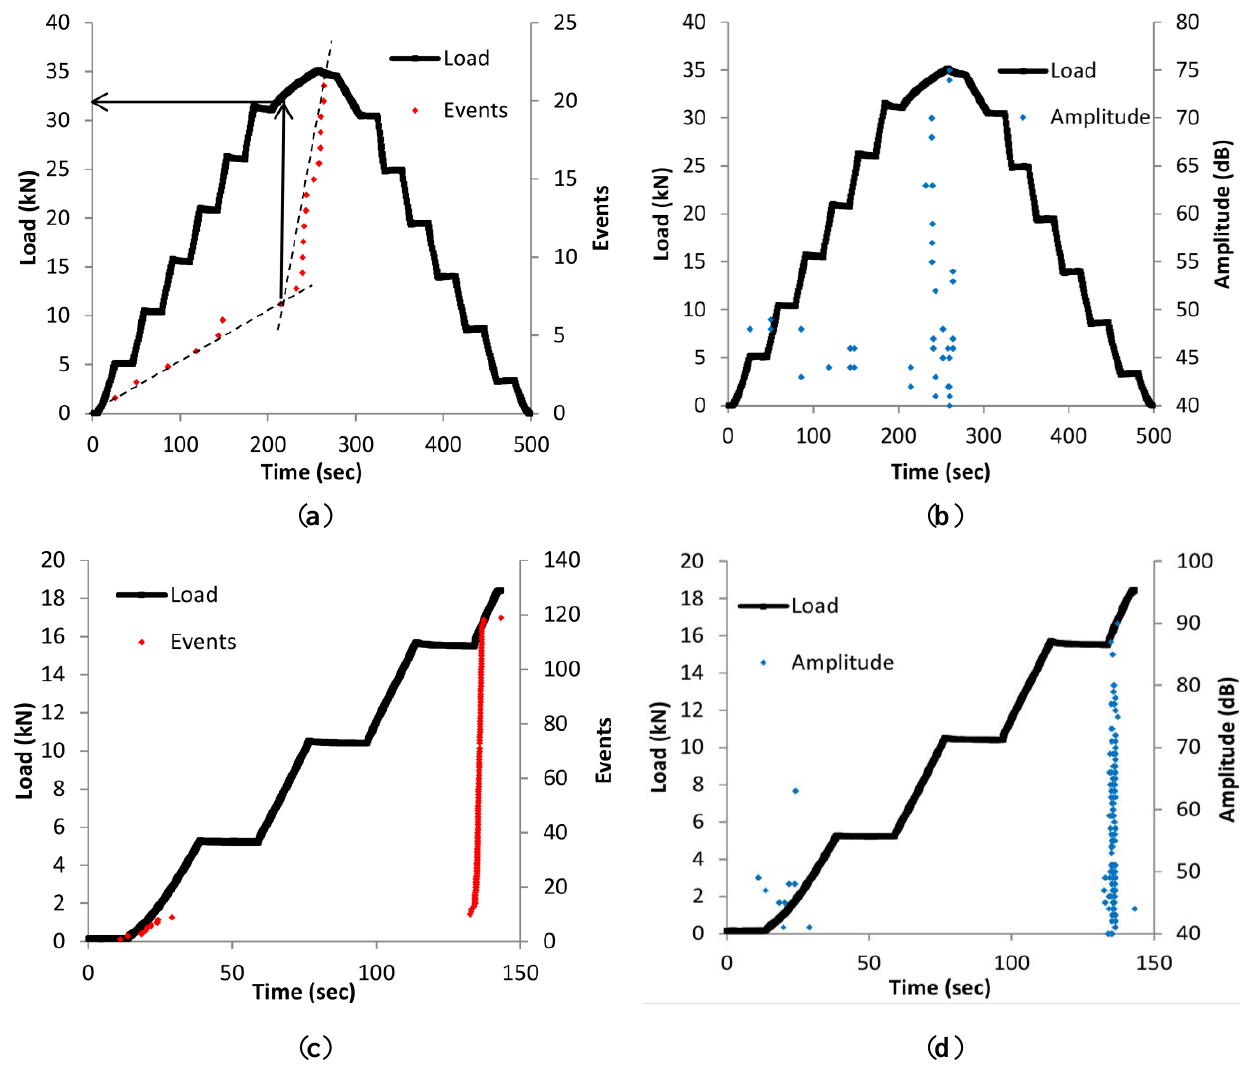
Figure 7. ( a ) Load history and number of events vs. time for the LMD2 sample; ( b ) load history and amplitude vs. time for LMD2 sample; ( c ) load history and number of events vs. time for the SLM1 sample; and ( d ) load history and amplitude vs. time for SLM1